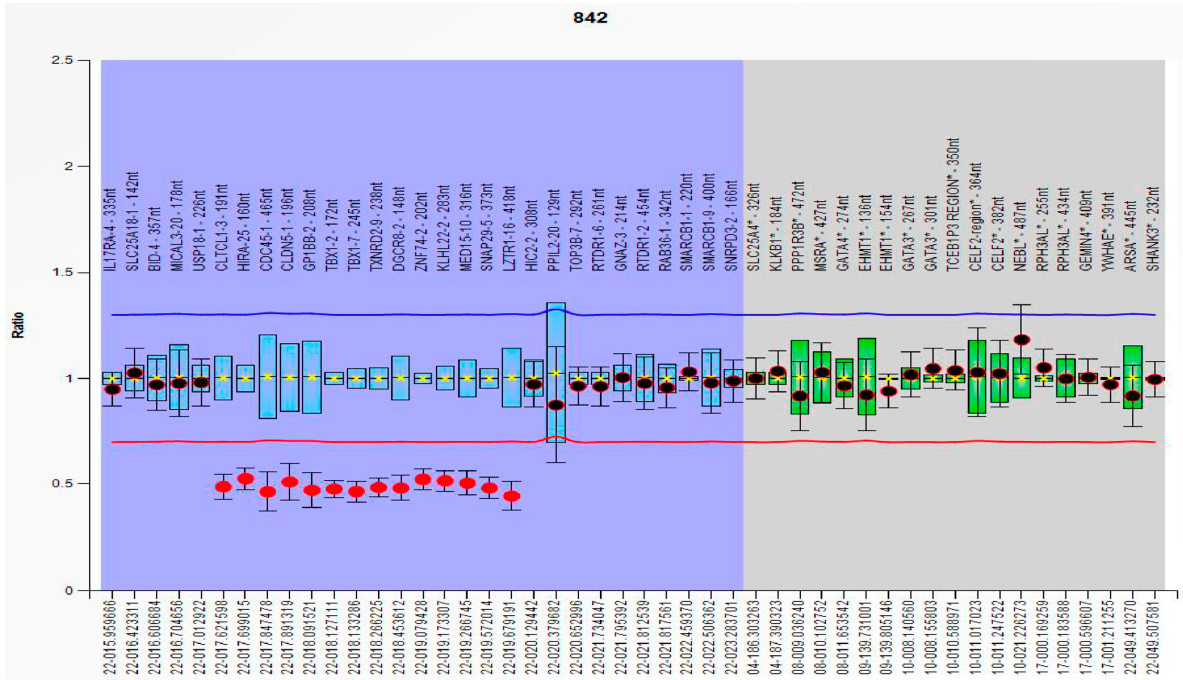
Figure 2. Distribution type graph showing the reference samples for the MLPA essay in BioRad2 for a patient positive (ID Lab No. 842) for 22q11.2 deletion syndrome. Red dots under the red line indicate the deletion of CTCL1-3, HIRA-25, CDC45-1, CLDN5-1, GP1BB-2, TBX1-2, TBX1-7, TXNRD2-9, DGCR8-2, ZNF74-2, KLHL22-2, MED15-10, SNAP29, and LZTR1. Black dots between blue and red lines indicate a normal genetic dosage.